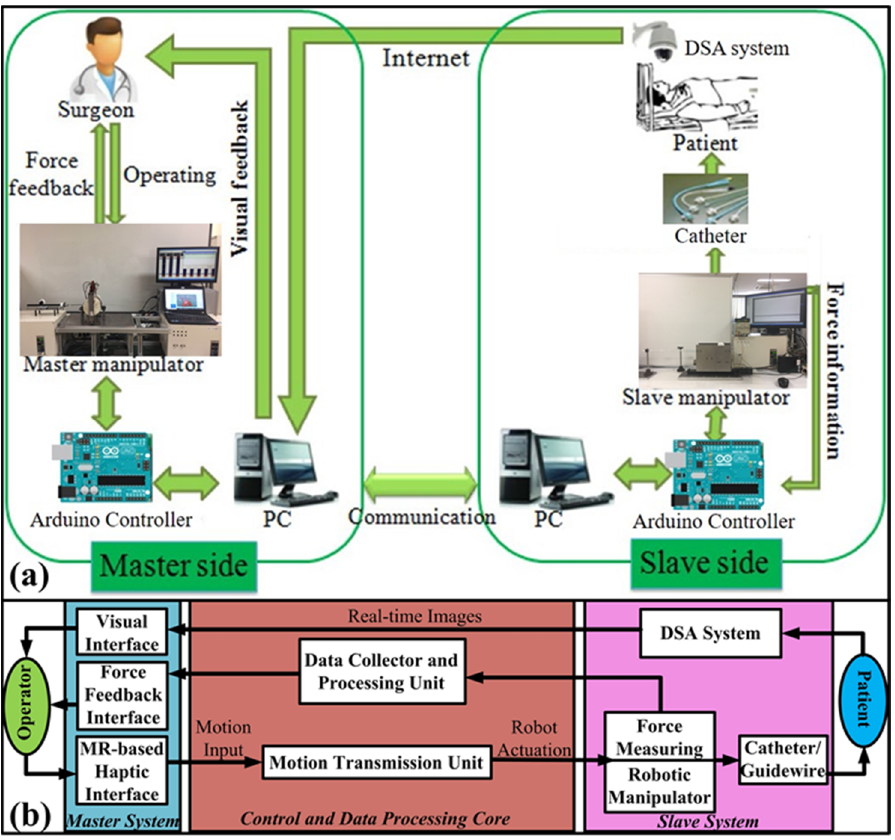
Figure 1. Overview of the endovascular robot-assisted catheter/guidewire operating system. ( a ) Schematic diagram of the proposed robot-assisted catheter/guidewire operating system. ( b ) Signal flow chart of the proposed robot-assisted catheter/guidewire operating system.